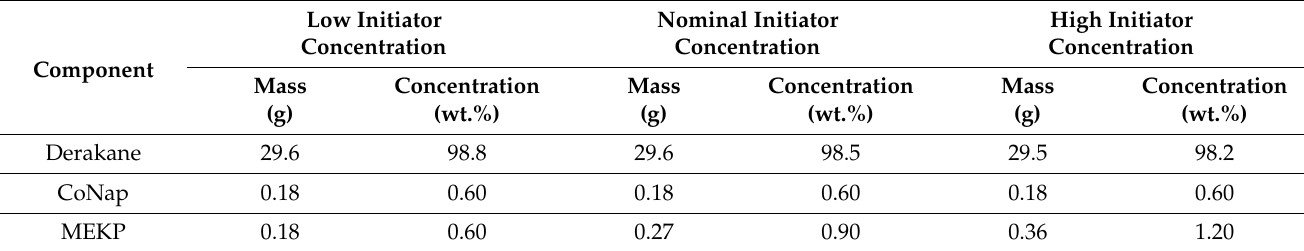
Table 1. Vinyl ester resin (VER) mixtures used to investigate the effect of varying the initiator concentration. Low Initiator Component